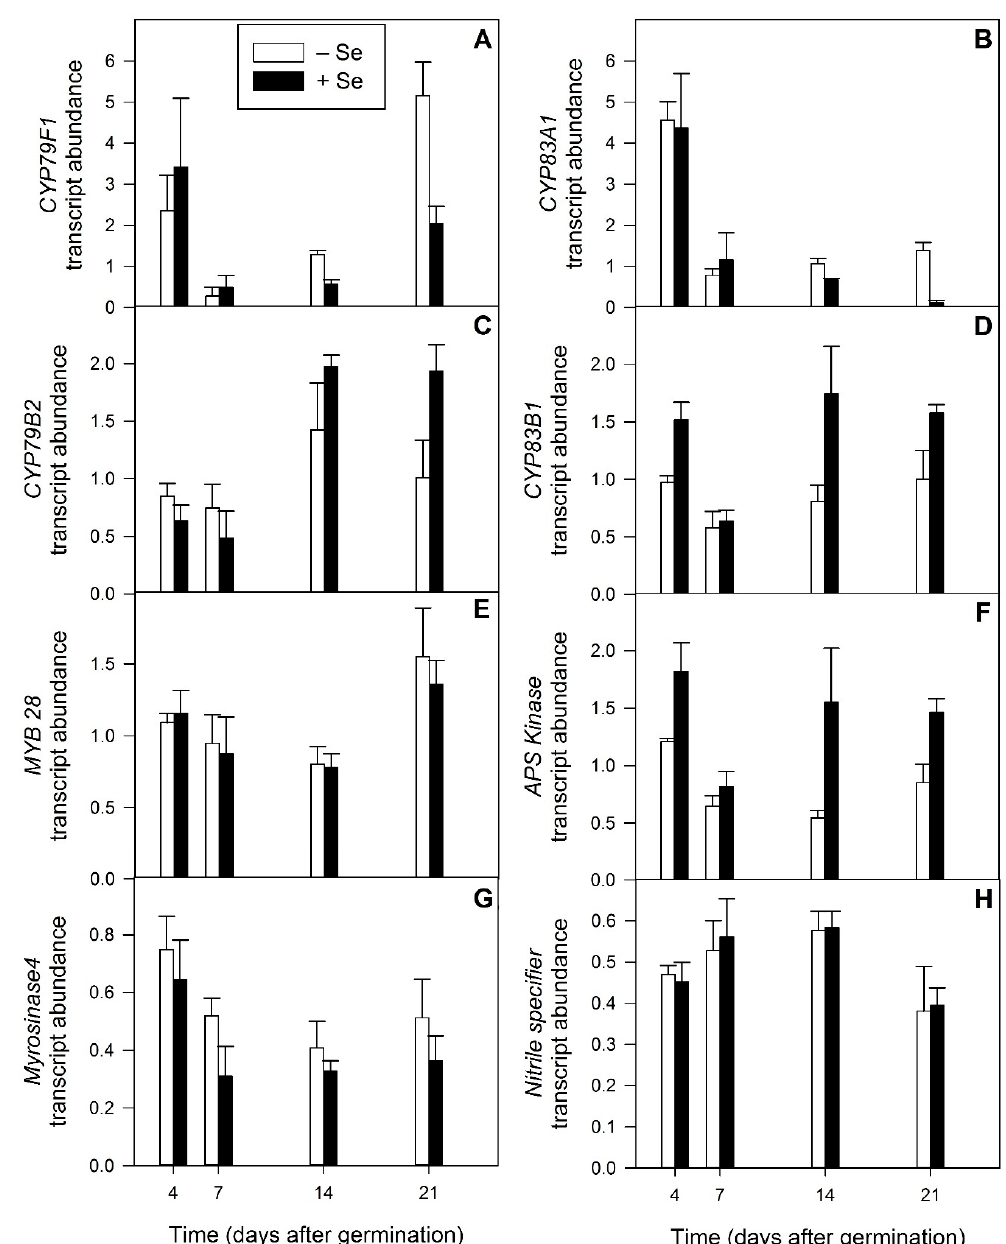
Figure 9. Transcript abundance of glycosinolate metabolism genes in Raphanus sativus plants at four developmental stages (4, 7, 14, 21 and 29 days after germination) grown hydroponically in the absence (white bars) and presence (black bars) of 40 µM sodium selenate. ( A ) CYP79F1 , ( B ) CYP83A1, ( C ) CYP79B2 , ( D ) CYP83B1 , ( E ) MYB28 , ( F ) APS Kinase ( G ) MYROSINASE4 , ( H ) NITRILE SPECIFIER . Transcript abundance was normalised to ACTIN7 . Each bar represents the mean value of three biological replicates, n = 3. Error bars represent the standard error of the mean.